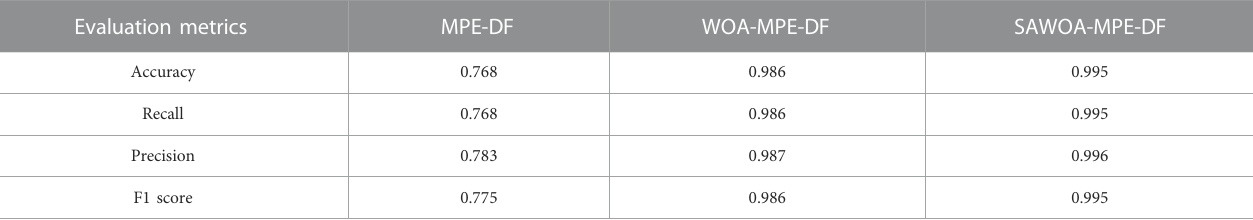
TABLE 6 Diagnostic performance of three methods. Evaluation